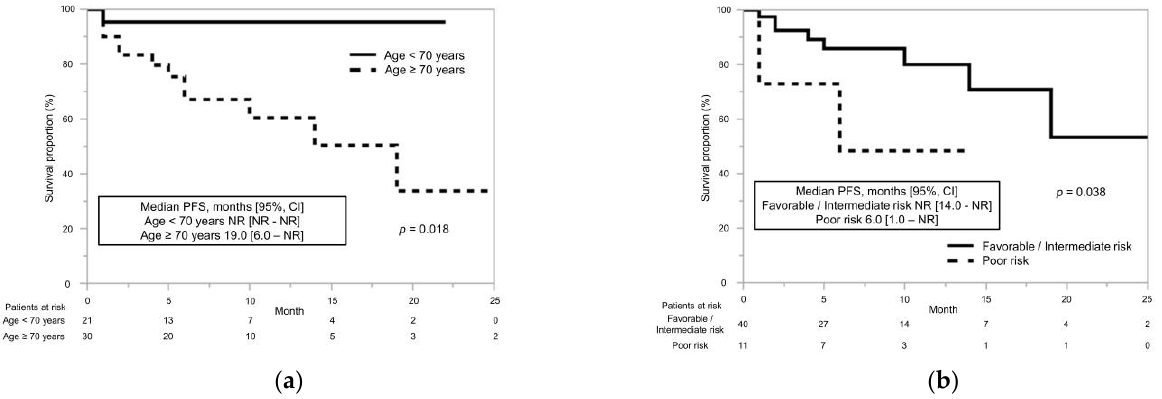
Figure 2. Progression-free survival (PFS) in patients with advanced or metastatic renal cell carci- noma (mRCC) who were administered immune checkpoint inhibitors and tyrosine kinase inhibitors (ICI+TKI) was estimated using the Kaplan – Meier method. ( a ) Patients with mRCC treated with ICI+TKI were divided by age, and their PFS was compared using the Kaplan – Meier method. The median PFS in patients with age ≥70 years was significantly shorter than that in patients with age <70 years (19.0 months vs. not reached (NR), p = 0.018) ( b ) Patients with mRCC treated with ICI+TKI were divided by the International Metastatic Renal Cell Carcinoma Database Consortium risk clas- sification. The median PFS was significantly shorter in patients with poor risk than in those with favorable/intermediate risk (6.0 months vs. NR, p = 0.038).